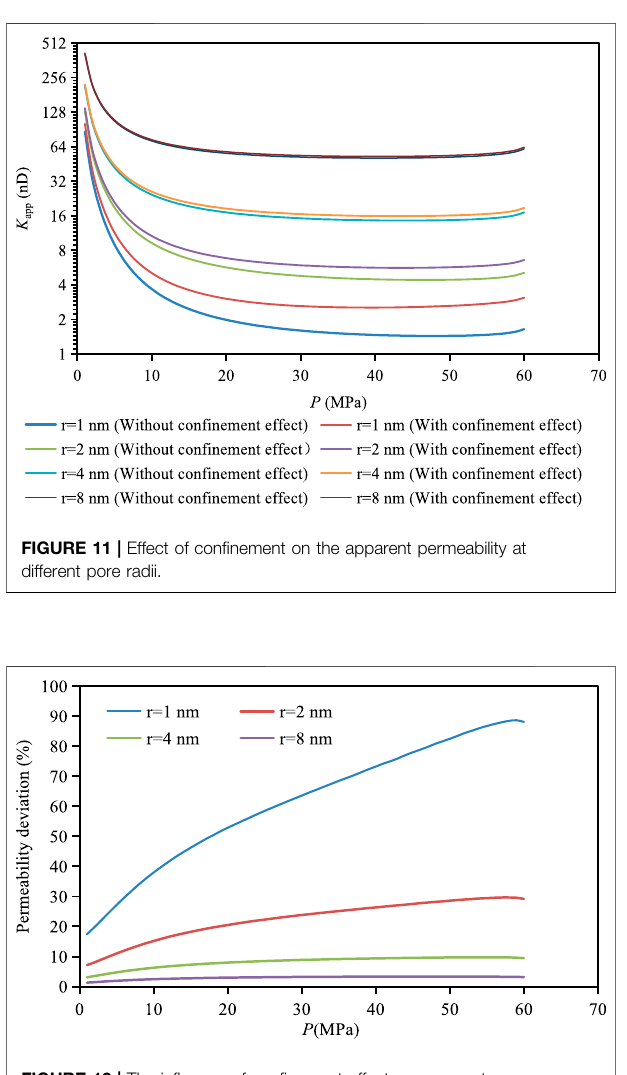
Frontiers in Earth Science |